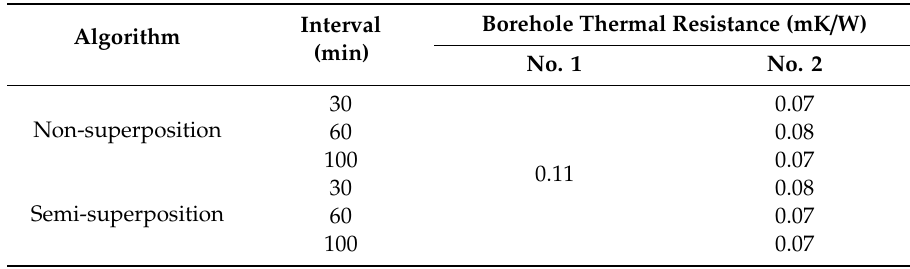
Figure 10. The borehole thermal resistance calculated at TRT No. 1 and No. 2 in which an example of data segmentation with 30 min interval was showed of TRT No. 2. Table 5. Comparing the borehole thermal resistance for a treated TRT with interrupted power input at a “stable” period with that of a TRT with stable power